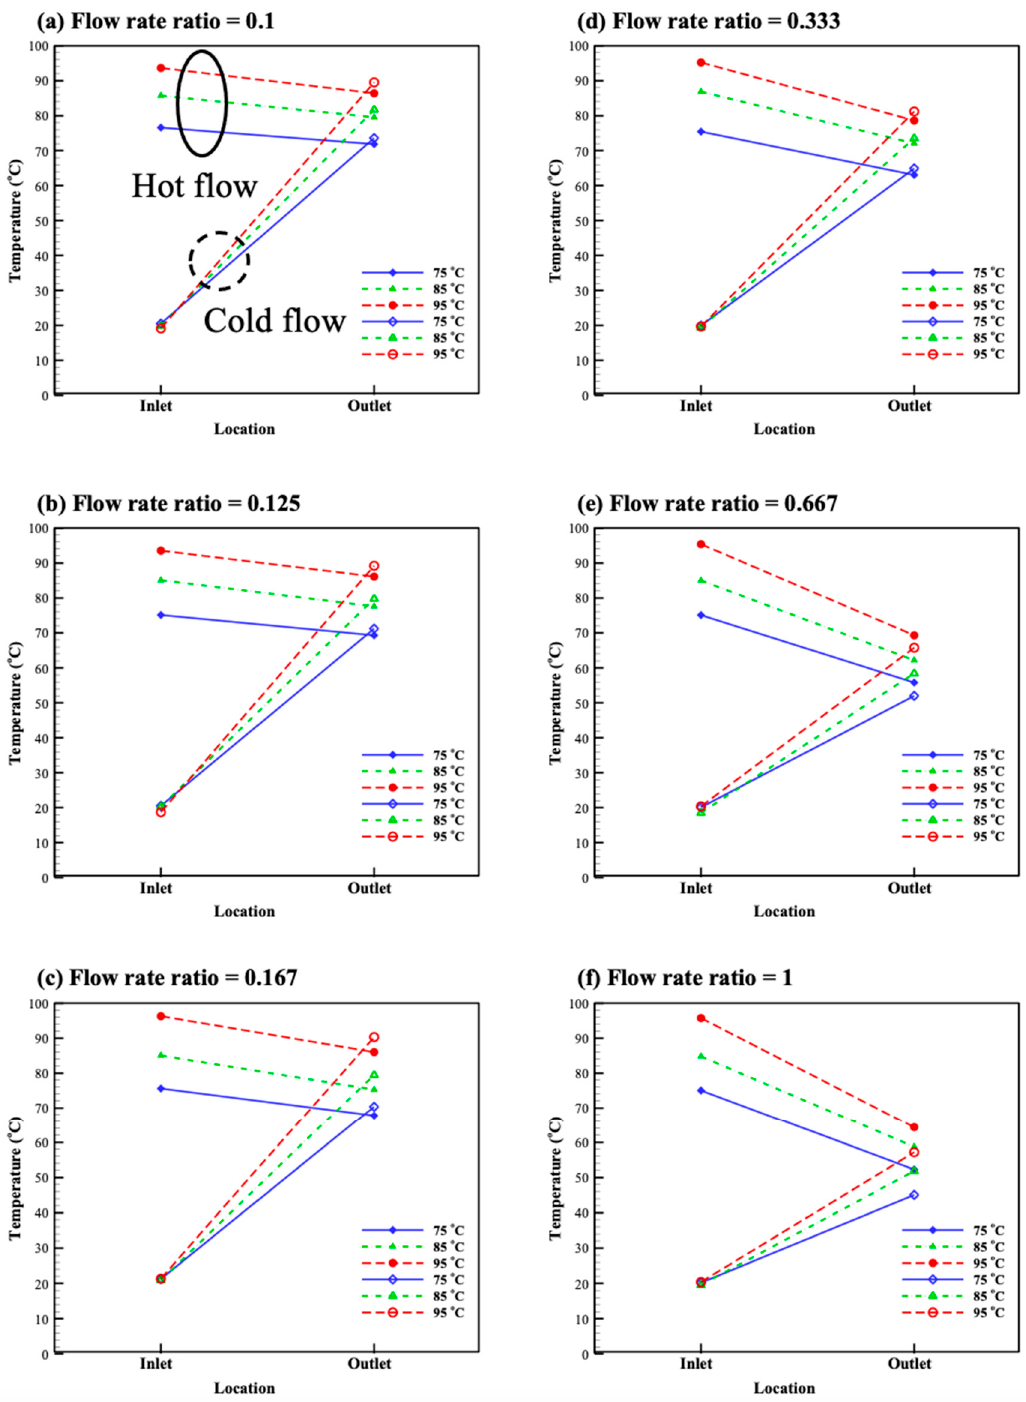
Figure 5. Temperature distributions of hot and cold fluid flow after heat exchange at flow rate ratios of ( a ) 0.1, ( b ) 0.125, ( c ) 0.167, ( d ) 0.333, ( e ) 0.667, and ( f ) 1.